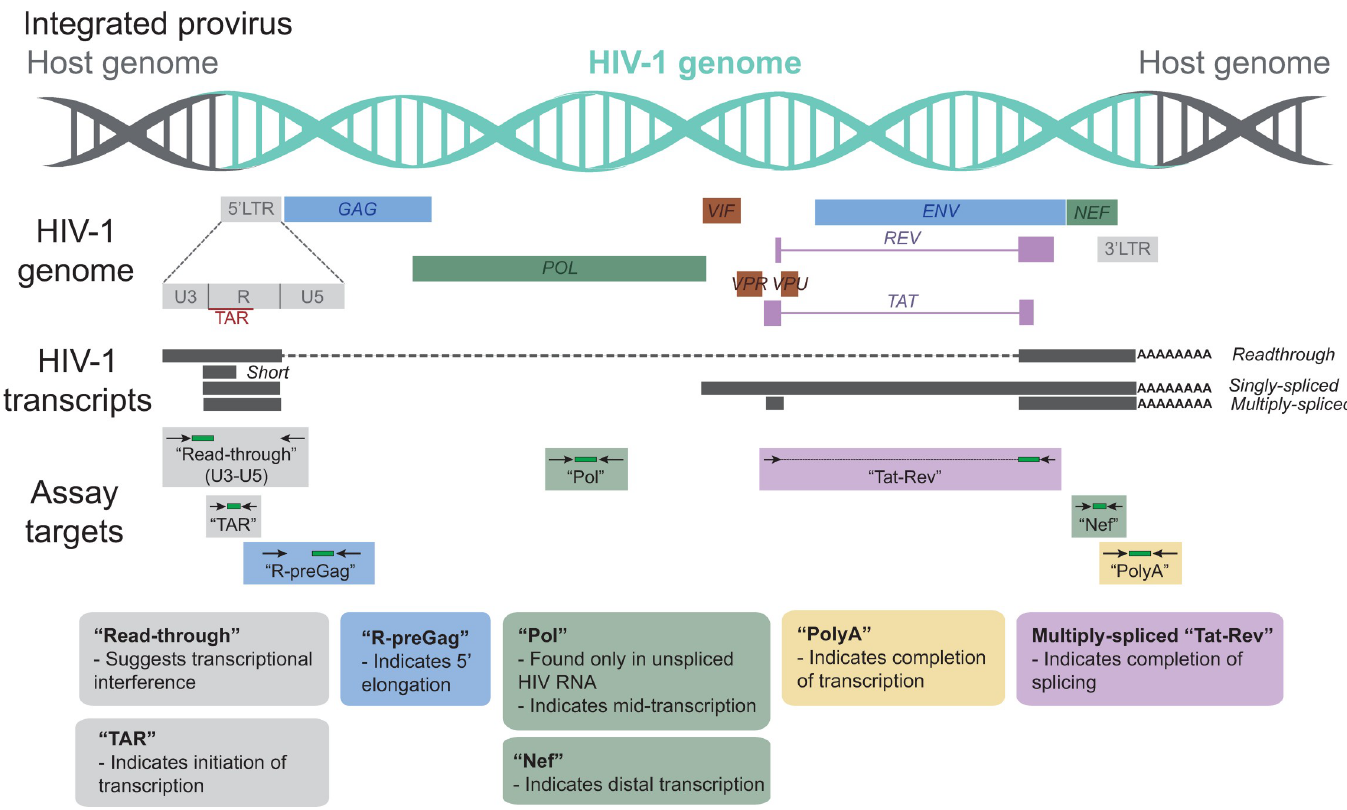
Fig 1. HIV genome and the targets for HIV transcription profiling assays. This schematic shows the genetic organization of proviral HIV DNA and the HIV “transcription profiling” assays targeting specific HIV RNA sequence regions that provide insight into blocks to transcription.